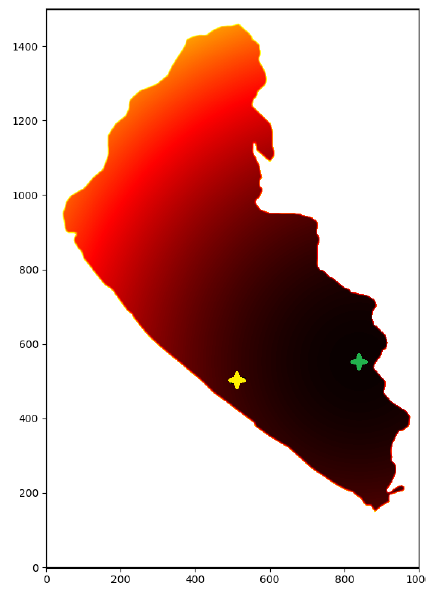
Figure 5. Generated potential map for a